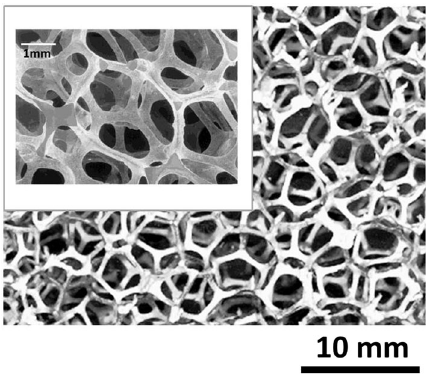
FIG. 2. A typical open cell metal foam, at two different viewing scales.